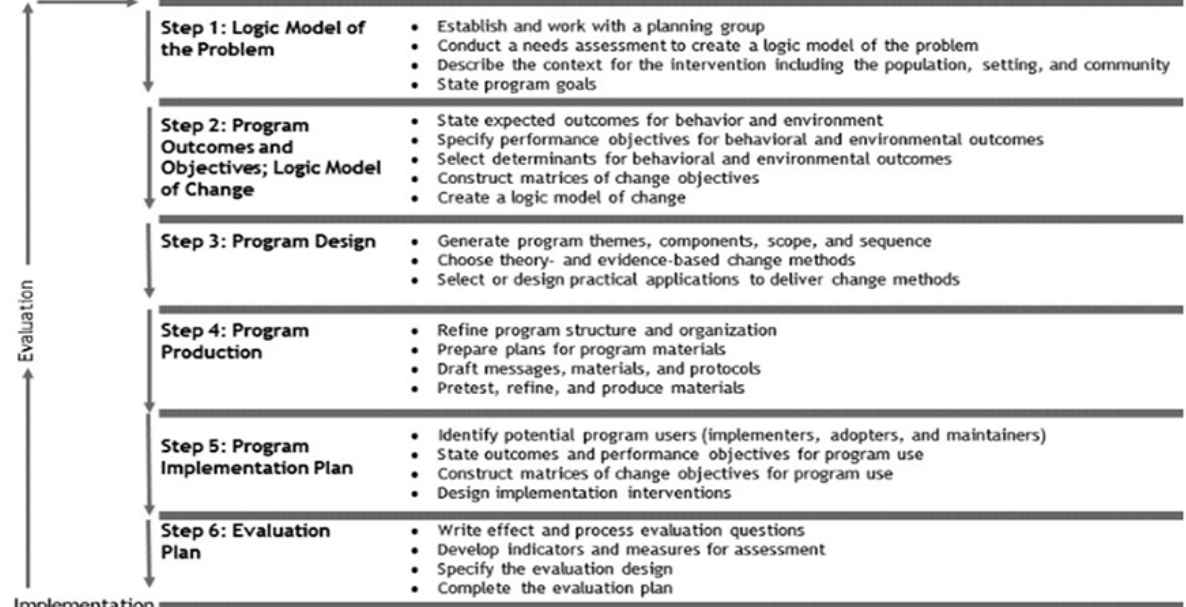
Figure 1. Intervention mapping framework,